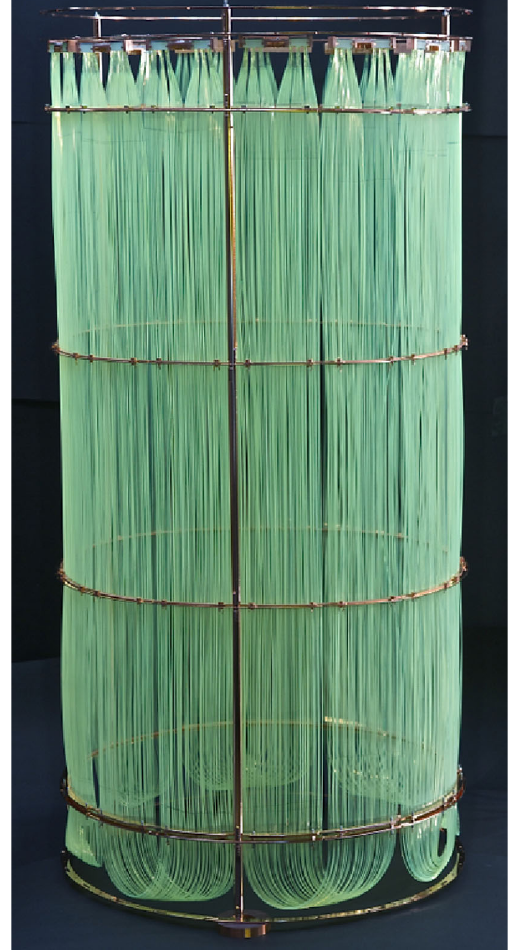
Fig. 14 The fiber curtain: height ∼ 1m, diameter ∼ 0 . 5m; 405 fibers read out on both ends by 90 SiPMs